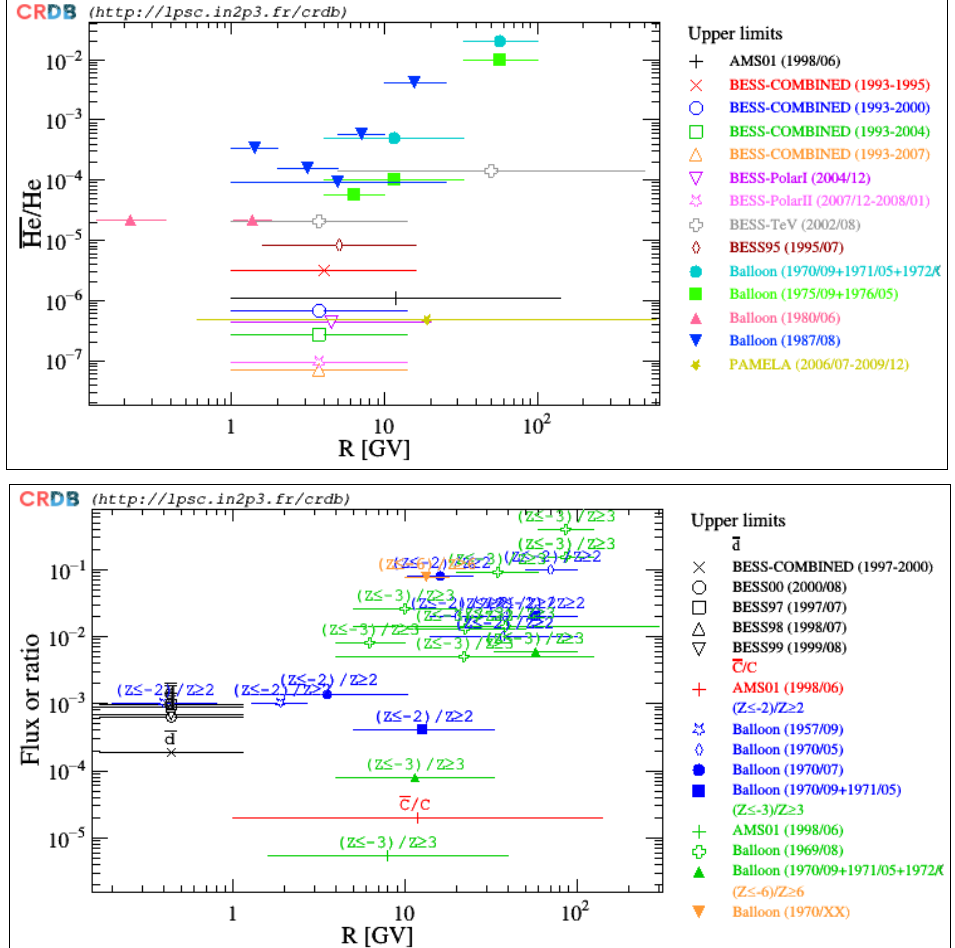
Figure 2. New antinuclear data in CRDB v4.0 . ( Top panel ): Upper limits on antihelium-to-helium ratio [10,77,86–94]. ( Bottom panel ): Upper limits on antideuteron flux [95] (black symbols) and various combinations of antielement-to-element ratios